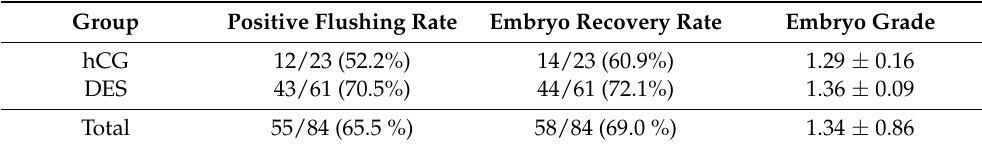
Table 8. Embryo recovery rate (ERR), positive flushing rate (PFR) and embryo morphological grade (EG: 1–4) in donor jennies treated with human chorionic gonadotropin (hCG) and deslorelin acetate (DES). Group Positive Flushing Rate Embryo Recovery Rate Embryo Grade hCG 12/23 (52.2%) DES 43/61 (70.5%) Total 55/84 (65.5 %) 58/84 (69.0 %) 1.34 ±